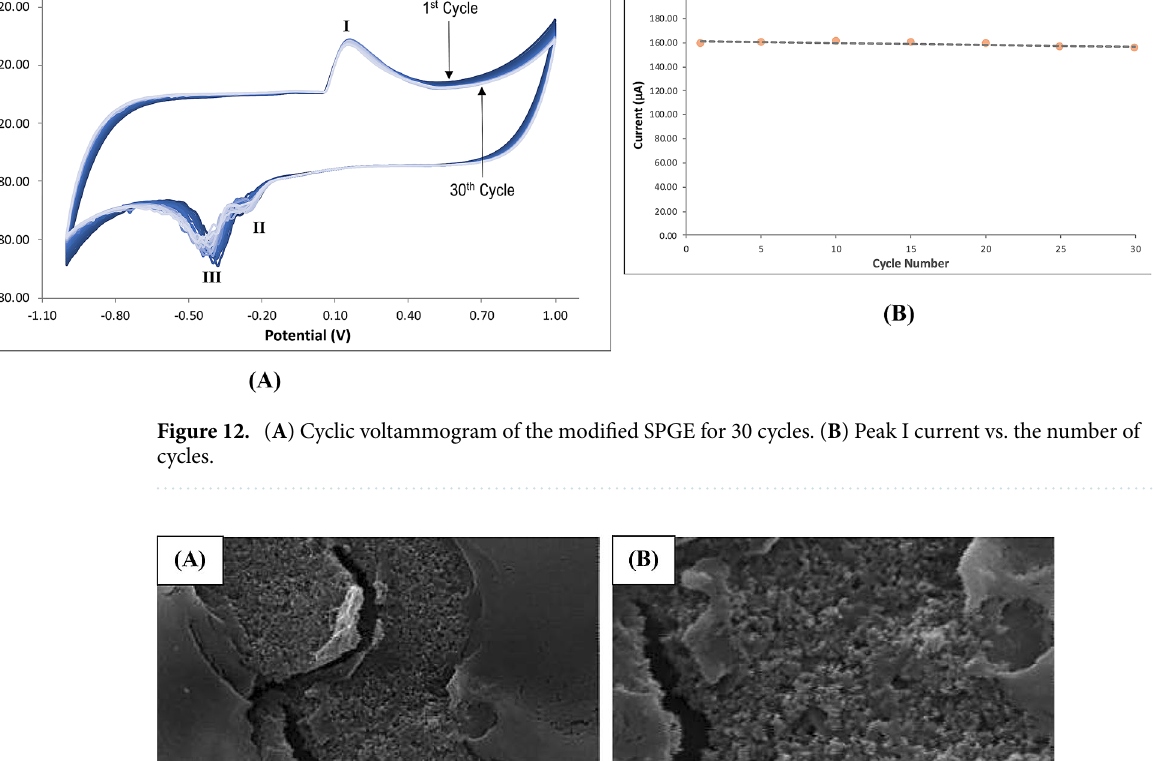
potential 0.15 V which corresponded to the combined peak of the reduction half-reaction of Bi + + e − → Bi and Ag + + e − → Ag 38 . On the other hand, the reverse scan from 1.0 V to − 1.0 V exhibited two cathodic peaks at the potential 0.25 V and 0.4 V. Due to agglomeration of AgNP, the cathodic peaks exhibited instability which can be seen in Fig. 12. The first cathodic Peak I refers to the oxidation half-reaction of Bi → Bi + + e − and Ag → Ag + + e − .